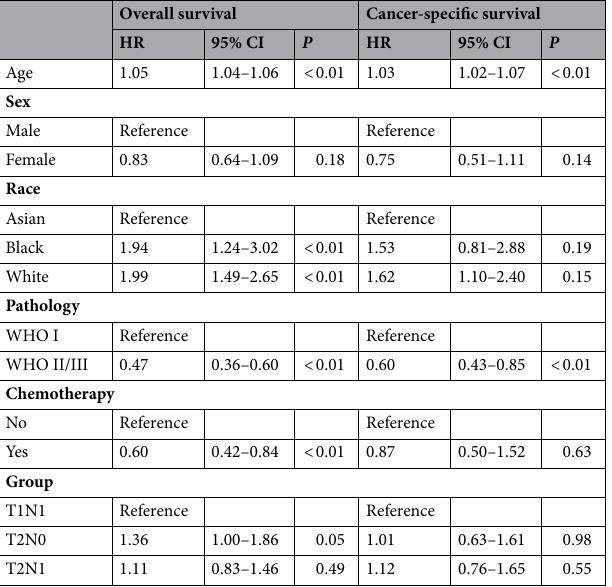
Table 2. Univariate regression analysis of overall survival and cancer-specific survival. WHO World Health Organization, HR hazard ratio, CI confidence interval.